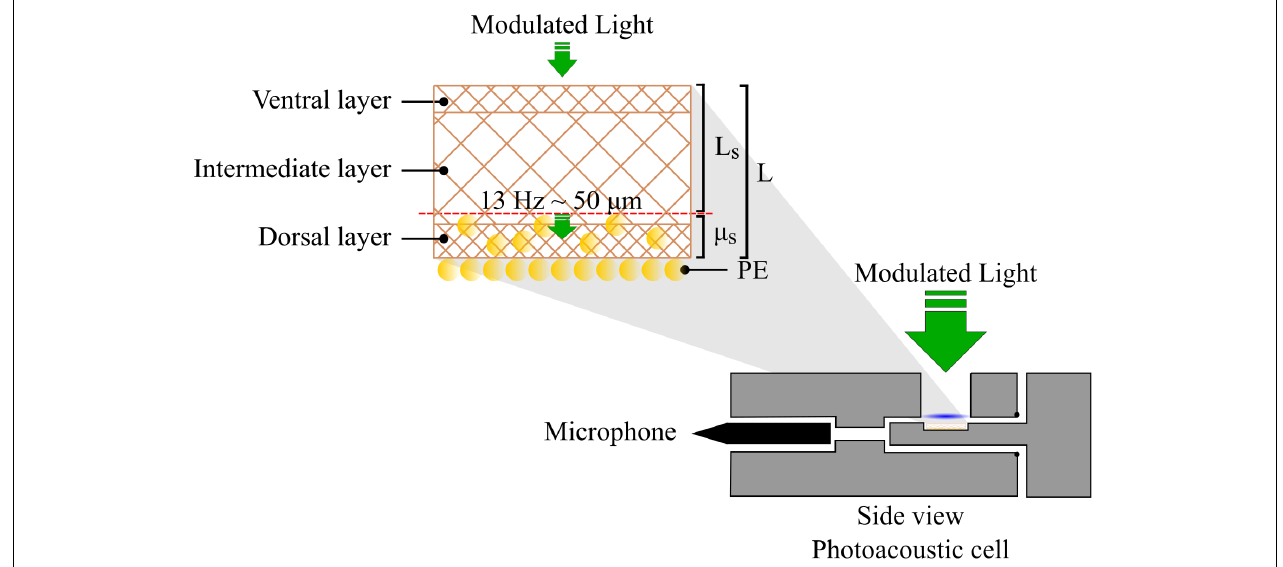
FIGURE 1 | Schematic diagram of placement of nail fragment with propolis extract (PE) in the photoacoustic cell. µ s = thermal diffusion length ( µ m); L = initial sample thickness ( µ m); Ls = field sample thickness ( µ m).